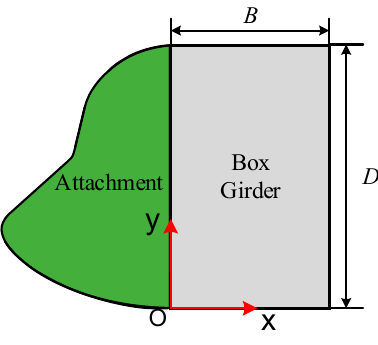
Figure 4. Bionic attachment scheme.